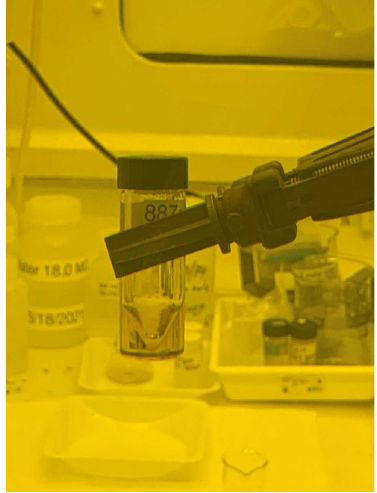
Figure 4. About 200 mCi of 88 Zr were produced at IPF at LANSCE. The radioactive material is diluted in 1 . 9 mol/L DCl. The image was taken inside a hot cell.